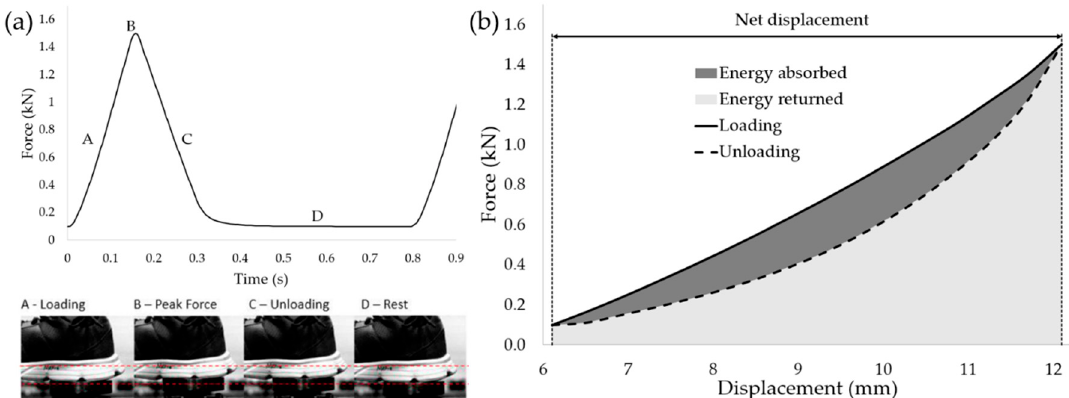
Figure 2. ( a ) Force vs. time profile for a loading cycle, with corresponding high-speed camera images (see supplementary video file), and ( b ) illustration of a force vs. displacement